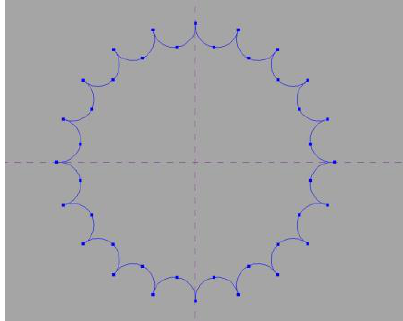
Figure 6. The result of workflow in Figure 5 at interface of Revit (source: Presentation of Kontoudaki’s thesis.)